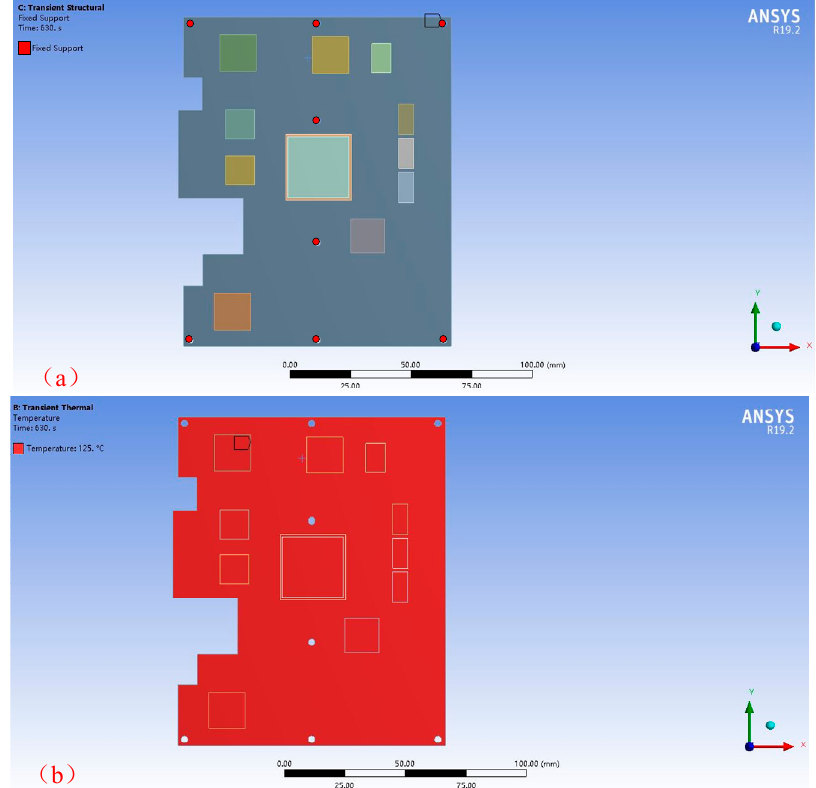
Figure 7. Boundary conditions and loads: ( a ) the eight corner screw holes with fixed support; ( b ) temperature loads applied on all the external surface of the specimen.